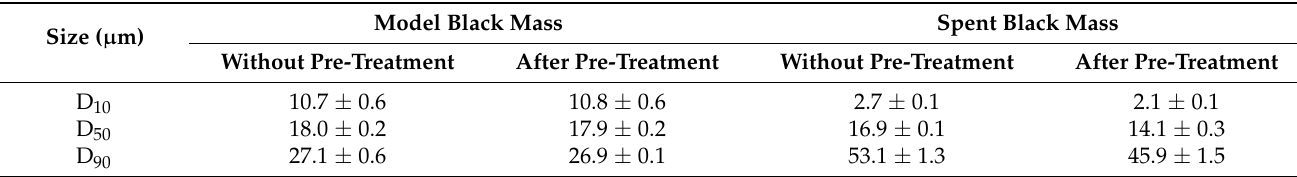
Table 1. Attrition pre-treatment effect on the PSD of the model black mass and spent black mass.